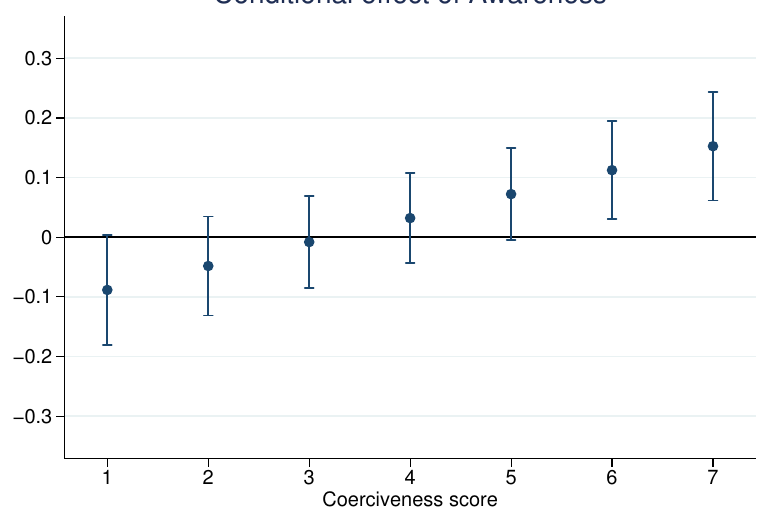
Figure 4. Conditional effect of awareness on policy acceptability in an interaction effect model. Note: Results of a linear regression of acceptability with policy fixed effects, topic fixed effects individual random effects, all identified acceptability factors, demographics, and an interaction term between awareness and